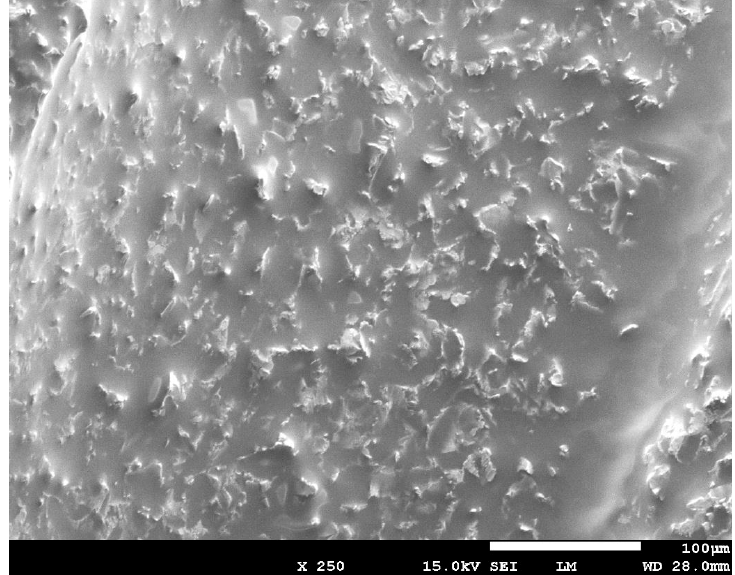
Figure 6. SEM view of the unlased but contaminated implant surface (Group C) showed the contaminants totally covering the roughness and the relief of the implant